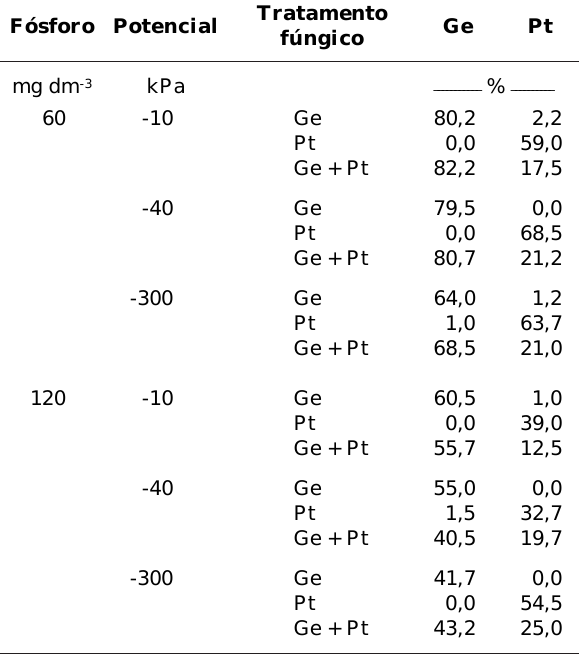
Quadro 2. Percentagem do comprimento